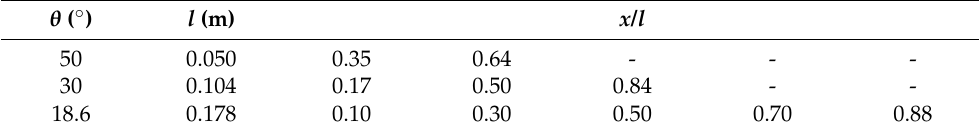
Figure 4. Dimensionless pressures p /( γ h ) on the horizontal step faces for the 50° to 18.6° slope reduction and d c / h = 4.6: ( a ) upstream of the slope reduction, ( b ) just downstream, and ( c ) “far” downstream; (···) 5th percentile, ( ― ) mean, and (---) 95th percentile. Table 2. Pressure transmitter positions on horizontal step faces (see Figure 3).